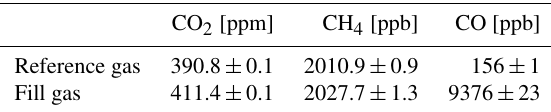
Table 2. The calibrated mole fraction values of the reference and fill